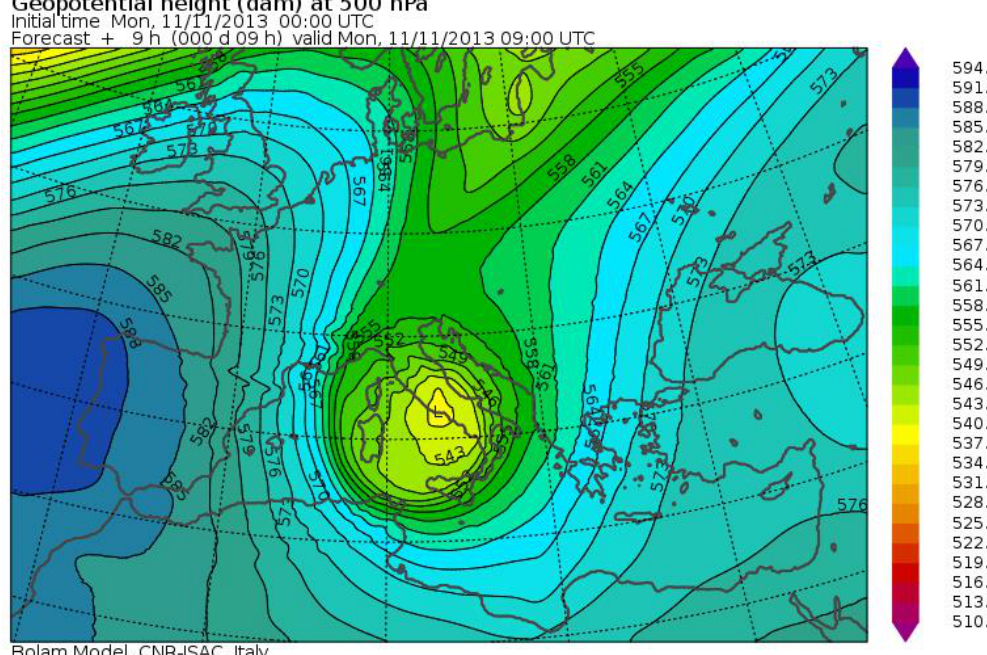
Figure 5. The starting conditions of the 500 hPa GPH of the precipitation events associated with flood F1 (see Table 1).